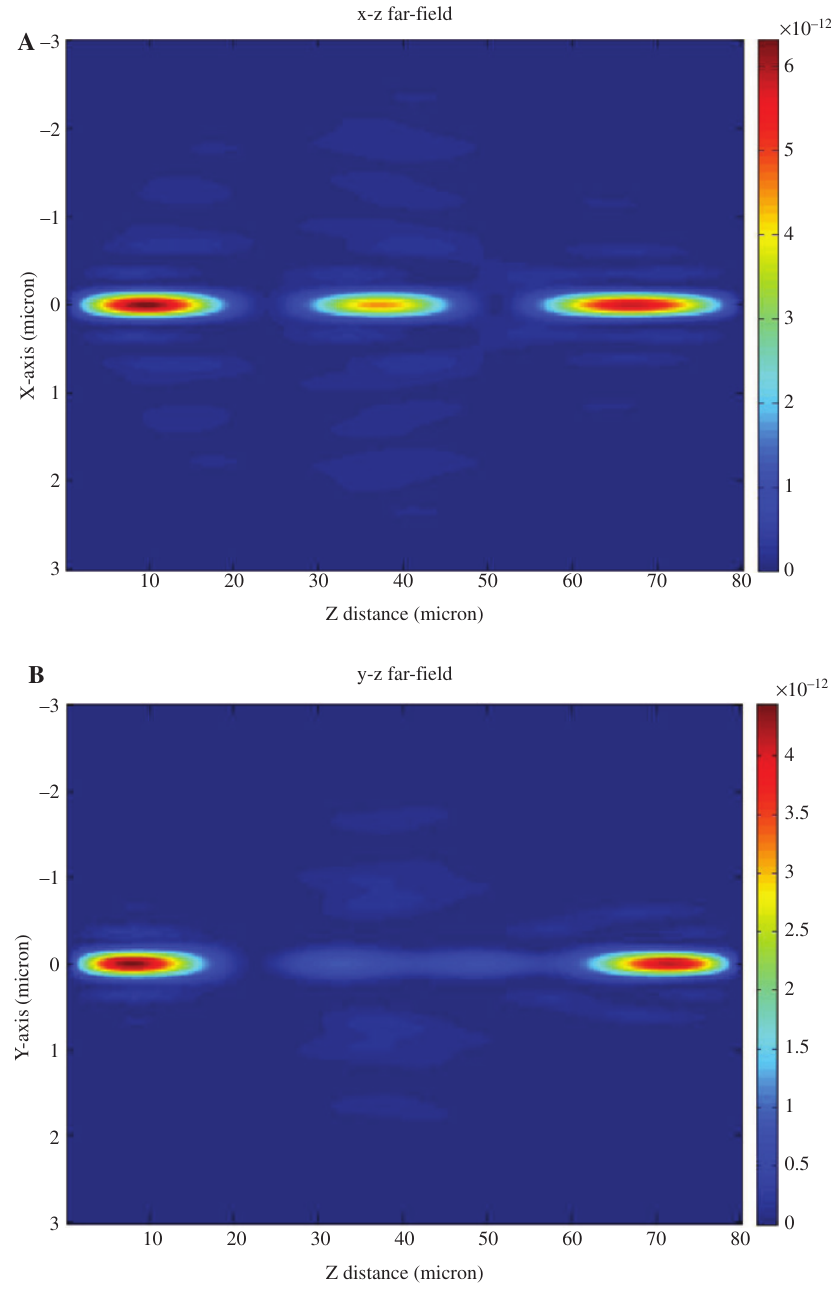
Figure 3: E-field intensity distribution of the metalens in free space. It shows beaming effect of the designed metallic structure at far field for the special case of k respectively. Interference between the collimated emitting beam and SPP waves occurs in free space. This is the reason why some focusing spots are observed at some intervals instead of a conventional continuously distributed collimated beam in the far-field of micron scale distance. The interference will disappear in the region of millimeter scale because intensity of the SPP wave decays to be zero already in this